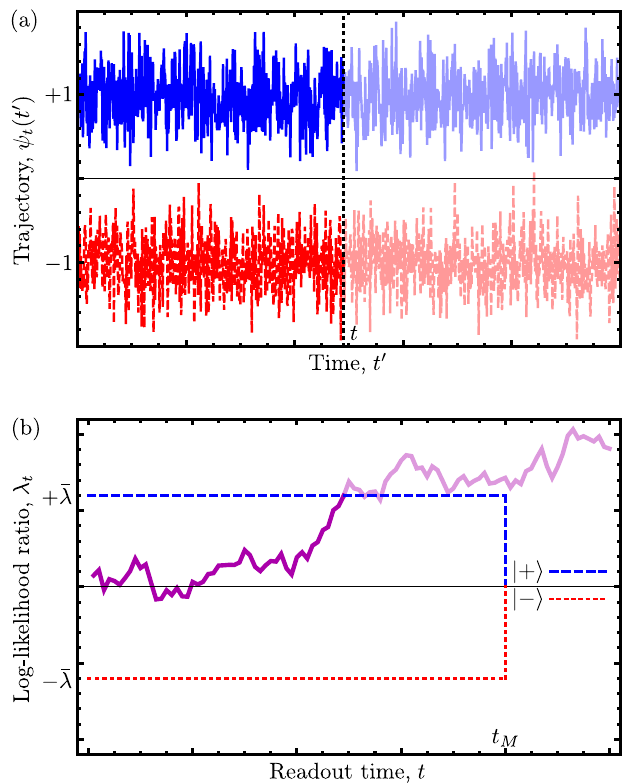
FIG. 1. (a) Readout trajectories for the Gaussian latching readout. The trajectory for state jþi (solid blue) has an average of þ 1 , while the trajectory for state j − i (dashed red) has an average of − 1 . Both trajectories have the same signal-to- noise ratio per unit time r . The identification of the state is made based on the entire trajectory acquired during the readout time t (dotted black). (b) Schematic representation of the adaptive decision rule for the Gaussian latching readout. As soon as the log-likelihood ratio λ (solid magenta) satisfies the stopping t ≥ ¯ λ , λ ≤ − ¯ λ or t ≥ t condition λ , data acquisition is stopped. t t M The sign of λ is then used to choose the qubit t state (dashed blue for jþi and dotted red for j − i ). Here, we choose jþi .